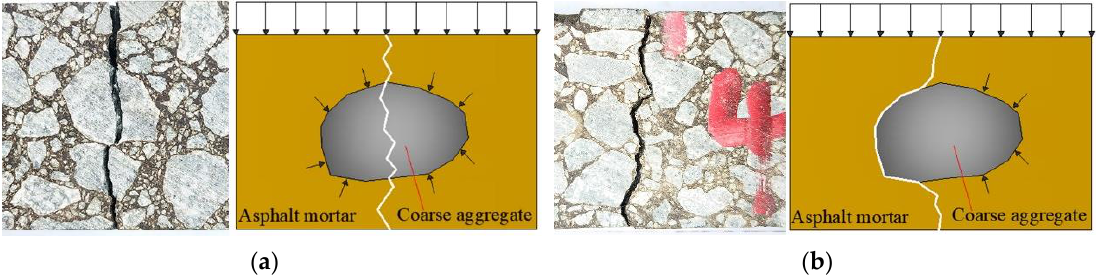
Figure 16. Fracture propagation by the crack path: ( a ) through an aggregate particle and ( b ) around an aggregate particle.